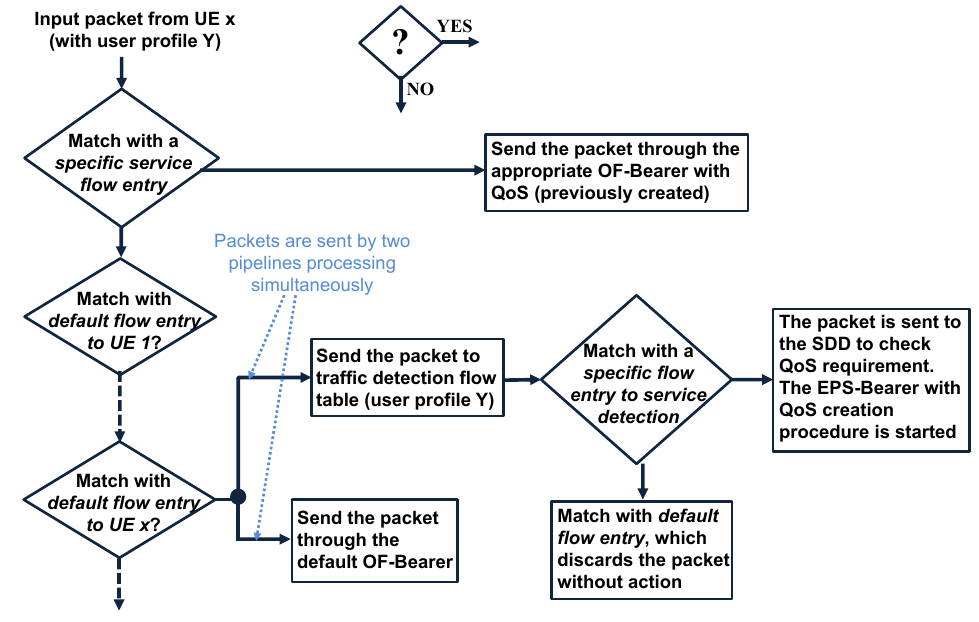
Figure 5. Flow diagram of traffic detection logic at